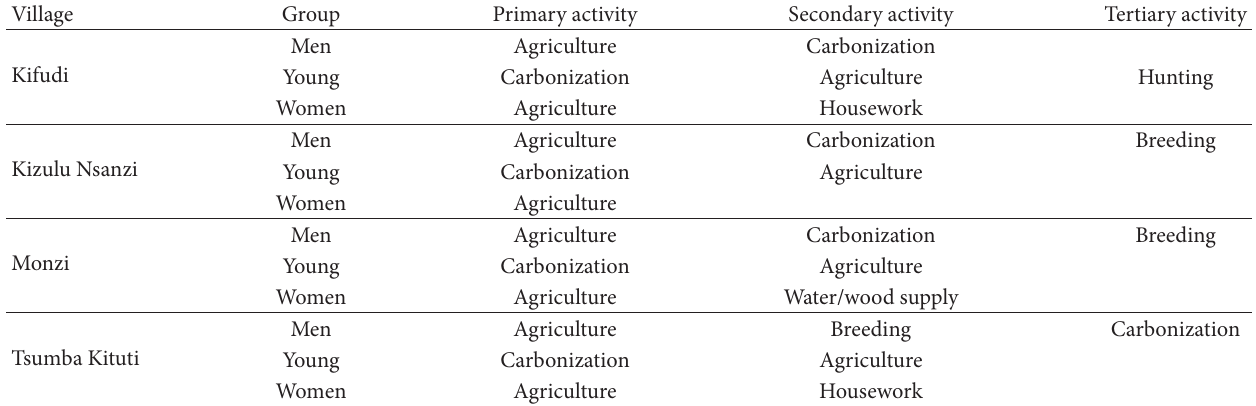
Table 2: Primary, secondary, and tertiary activities practiced by groups in the selected villages. Village